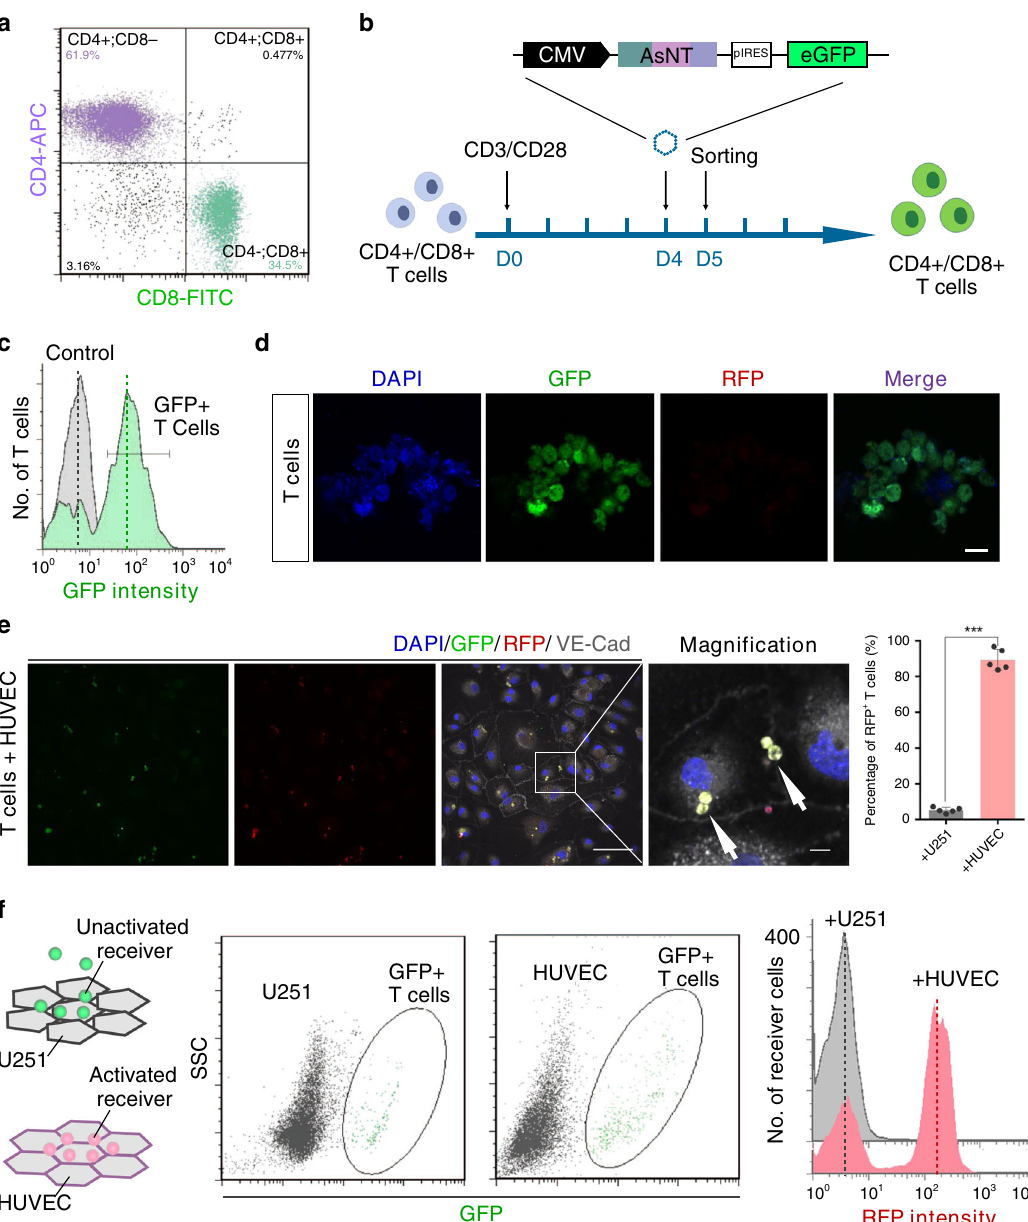
Fig. 4 CD4 + and CD8 + T cells can be customized with AsNRs. a In all the experiments, a mixture of CD4 + and CD8 + T cells were used (~2 : 1). b , c Due to the low ef fi ciency of T-cell transfection (<20%), GFP-positive T cells were sorted by fl ow cytometry, and ∼ 85% were retrieved. d Image of fl uorescence showing very low basal activation in the T cells engineered with AsNRs. e Immunostained VE-cad in slices showing that engineered T cells turned red when they engaged in cross talk with endothelial cells ( n = 5 slices per group). f Analysis of adherent T cells showed that HUVECs attracted more engineered T cells than did the U251 cells. The graph on the right shows the number of activated engineered T cells, which indicated that these T cells could sense HUVECs. Scale bars = 10 μ m in d ; 50 μ m in e , and 10 μ m in the magni fi ed panel. Error bars: SEM. Signi fi cance: *** p <